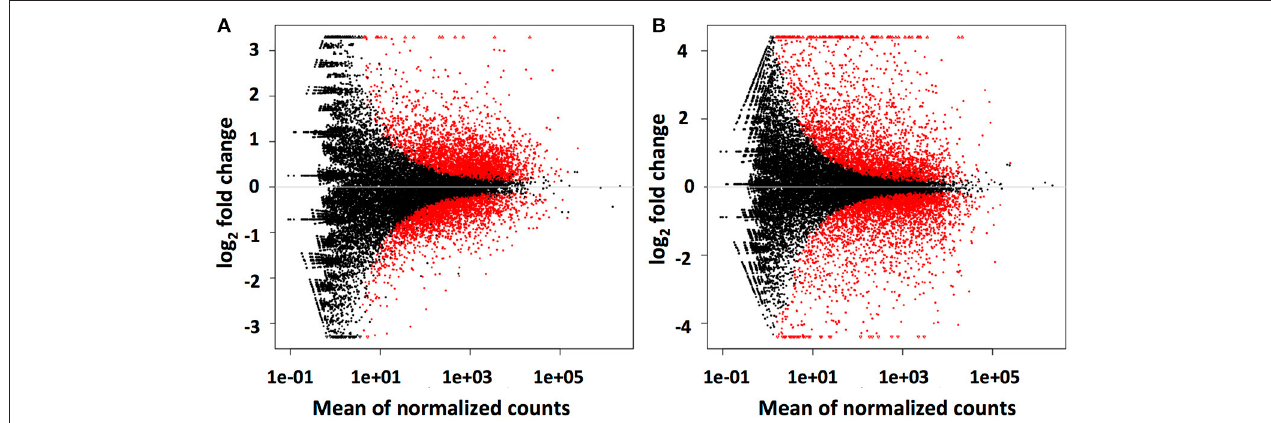
FIGURE 3 | Differential regulation of Trinity assembled AMC941 C. rosea unigenes . Volcano plots of differential gene expression relative to meOH treated C. rosea for, (A) 5 ppm DON treated and (B) Fusarium -spent media (containing live macroconidias) treated C. rosea . Volcano plots were obtained using DESeq2 software (Varet et al., 2016 ).